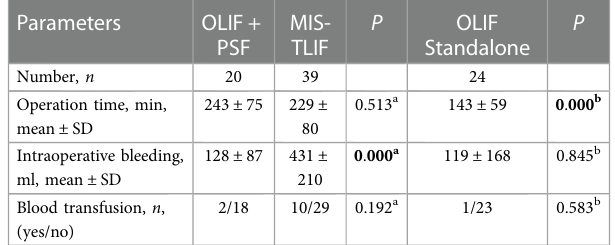
TABLE 3 The general comparison of OLIF+PSF, OLIF standalone and MIS-